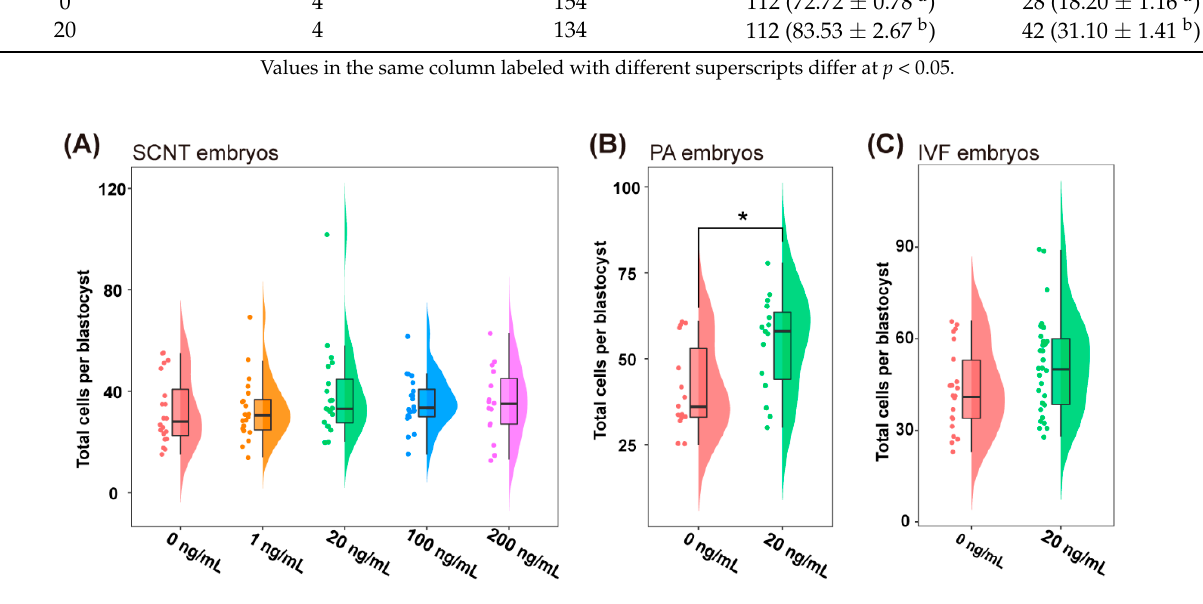
Figure 2. Effects of supplementation of SDF1 during pig oocyte IVM on the total cell number per blastocyst of SCNT ( A ), PA ( B ), and IVF ( C ) embryos. “*” represents p < 0.05.